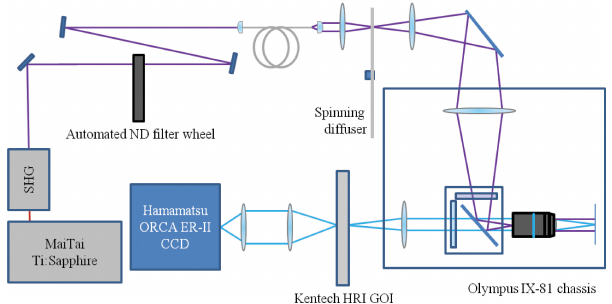
Fig. 1. Schematic of experimental con¯guration of plate reader equipped for auto°uorescence lifetime imaging. The microscope chassis is equipped with motorized stage, ¯lter cube cassette and objective nosepiece as well as an autofocus unit to facilitate automated acquisition. Time resolved imaging is im- plemented using a GOI. (SHG: second harmonic generation, ND ¯lter: neutral density ¯lter, GOI: gated optical